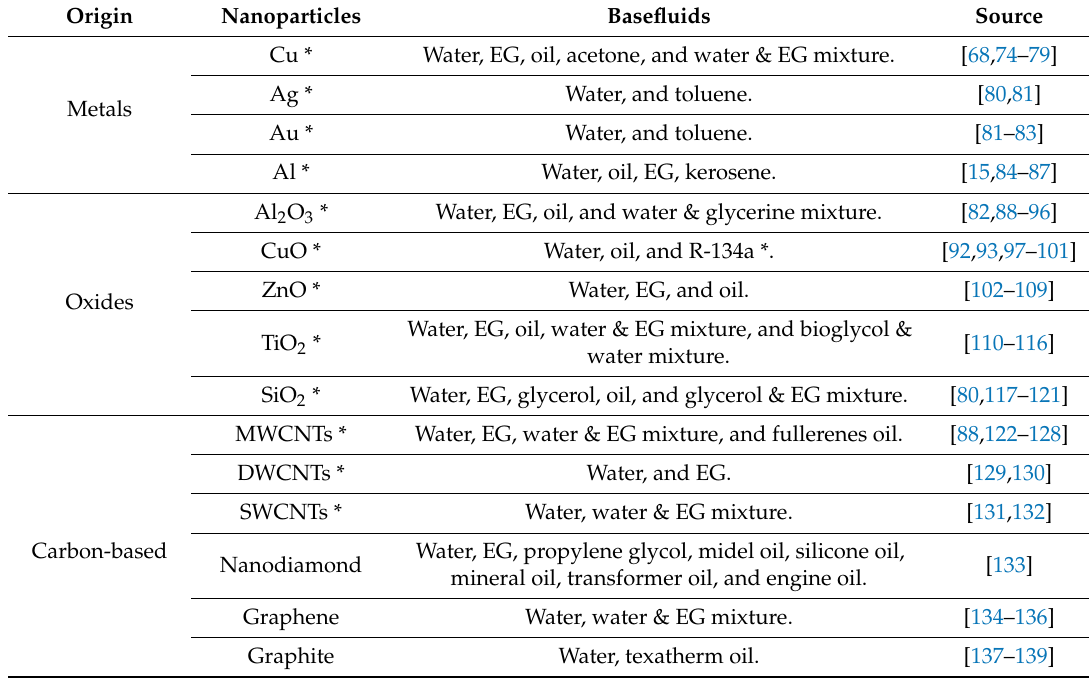
Table 1. Di ff erent types of nanoparticles and basefluids used in fabricating